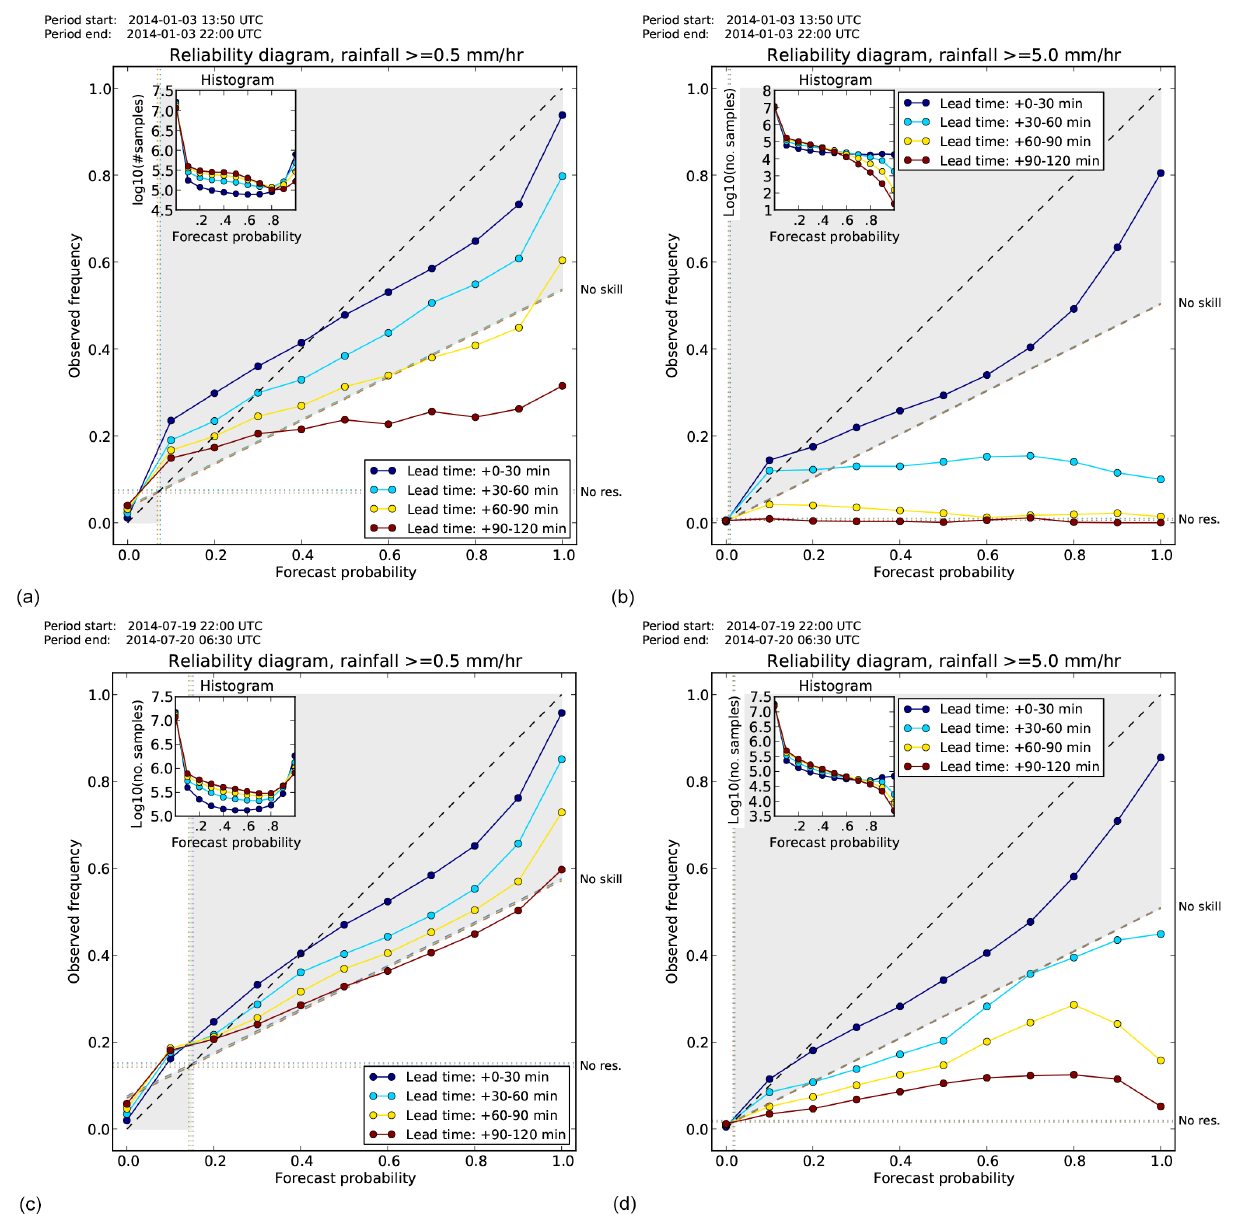
Figure 7. Reliability diagrams for the Ghent case on 3 January 2014 relative to the probabilistic forecast of exceeding (a) 0.5mmh − 1 and (b) 5.0mmh − 1 . (c, d) Same as (a, b) but for the Leuven case on 19–20 July